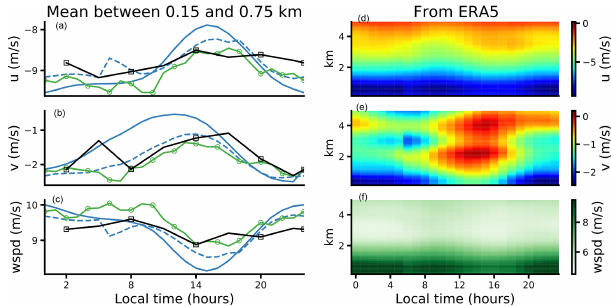
Figure 7. Diurnal cycle of zonal wind (a, d) , meridional wind (b, e) , and wind speed (c, f) . The left column (a–c) refers to the layer between 0.15 and 0.75km with values from radiosondes (black squares), lidar (green circles), ERA5 (dashed blue), and the fore- cast (solid blue). The right column (d–f) refers to multiple levels from the surface to 5km with values from ERA5